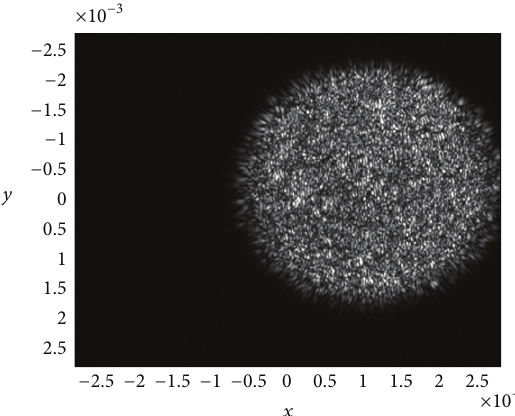
Figure 1: Experimental interferometric out-of-focus image of a NaCl salt crystal. All axes are in meters.